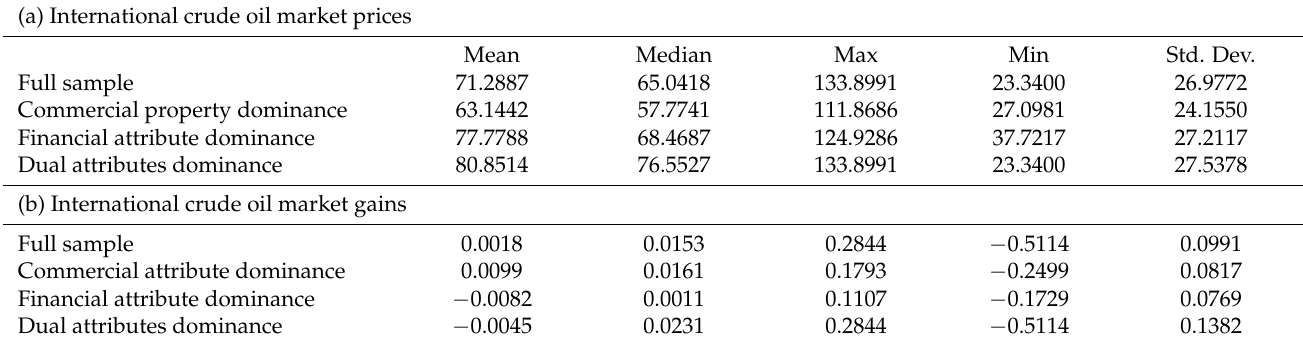
Table 6. Descriptive analysis of international oil prices and returns under different oil